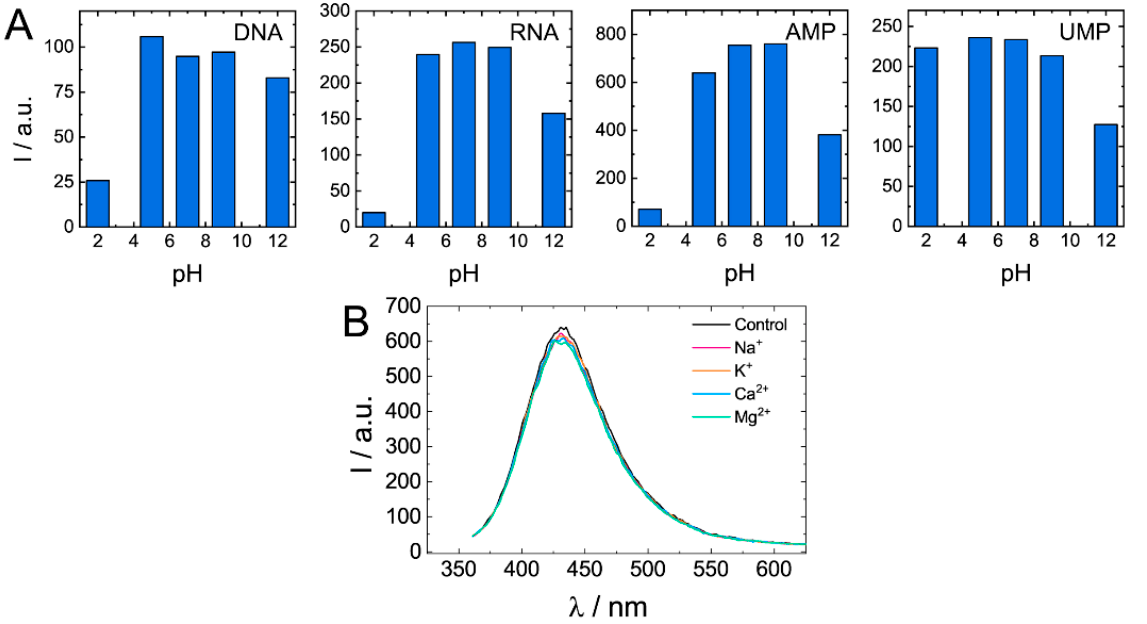
Figure 8. Dependences of biodots fluorescence on pH and the presence of physiologically relevant cations. ( A ). Fluorescence intensities of biodots of DNA, RNA, AMP, and UMP in solutions of various pHs at the excitation wavelength λ ex = 375 nm. ( B ). Fluorescence spectra of DNA biodots in solutions containing 0.33 mM of biologically relevant mono- and dications at the excitation wavelength λ ex = 375